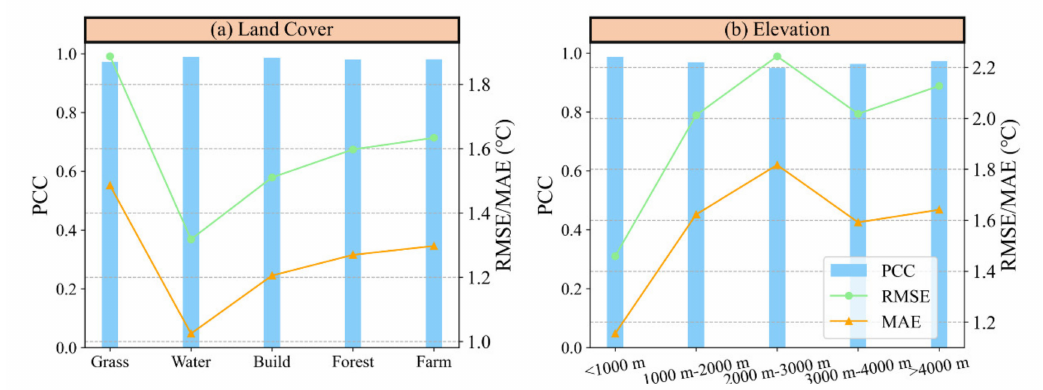
Figure 13. Model performance in different land cover types (grassland, farmland, forest, building, and water) and ranges of elevation (<1000 m, 1000~2000 m, 2000~3000 m, 3000~4000 m, >4000 m). The blue, orange, and green colors represent PCC, MAE, and RMSE,